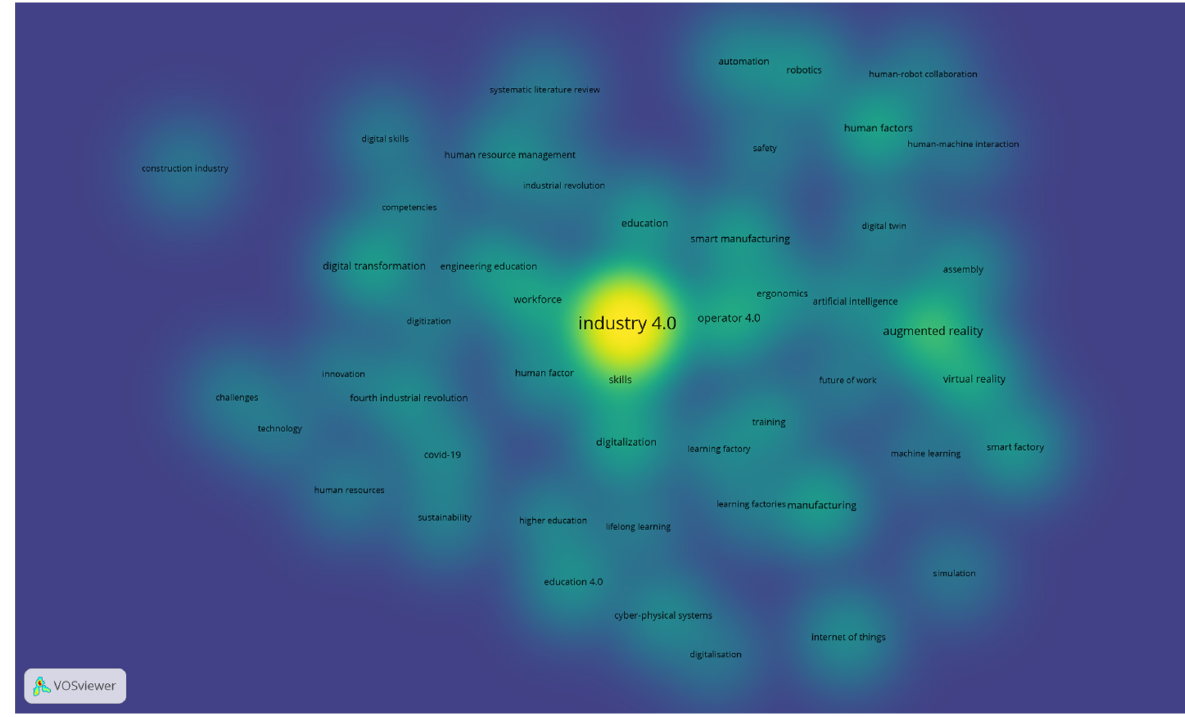
Figure 3. Database by keywords. Source: based on Scopus database edited by authors.